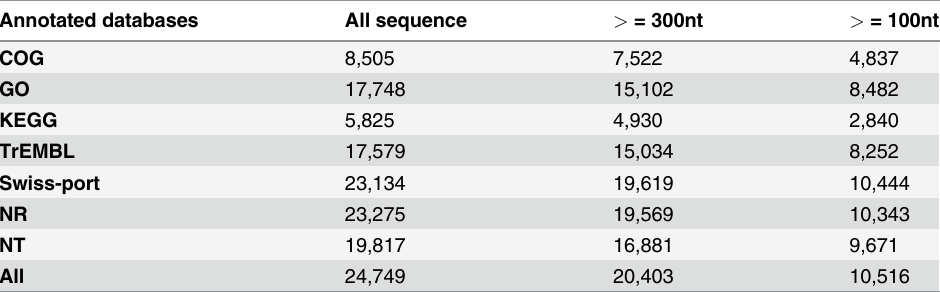
Table 2. Functional annotation of the A . comosus var. bracteatus